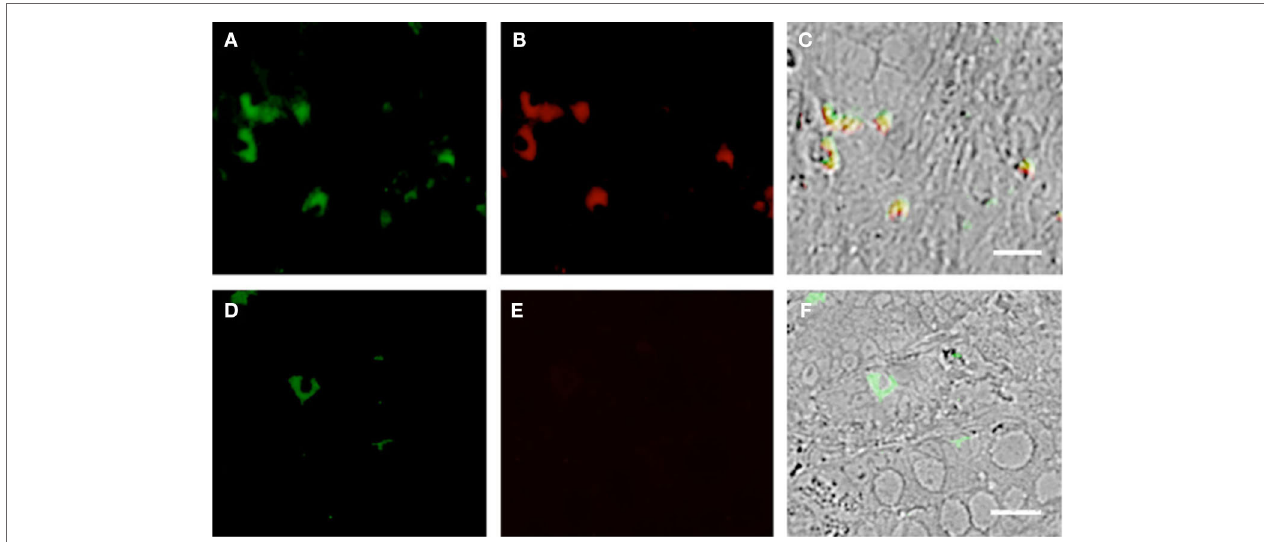
FigUre 6 | Duodenum biopsies of hiV/aiDs cases and controls evaluated for coexpression of cD303 (green) and cD11c (red) . Bar represents 20 μ m. (a) HIV case duodenum biopsies probed with a monoclonal FITC-anti-CD303 antibody. (B) HIV case duodenum biopsies probed with monoclonal APC-anti-CD11c antibody. (c) HIV case duodenum biopsies DIC image merged with (a,B) . (D) Control duodenum biopsies probed with monoclonal FITC-anti-CD303 antibody. (e) Control duodenum biopsies probed with monoclonal APC-anti-CD11c antibody. (F) Control duodenum biopsies DIC image merged with (D,e)